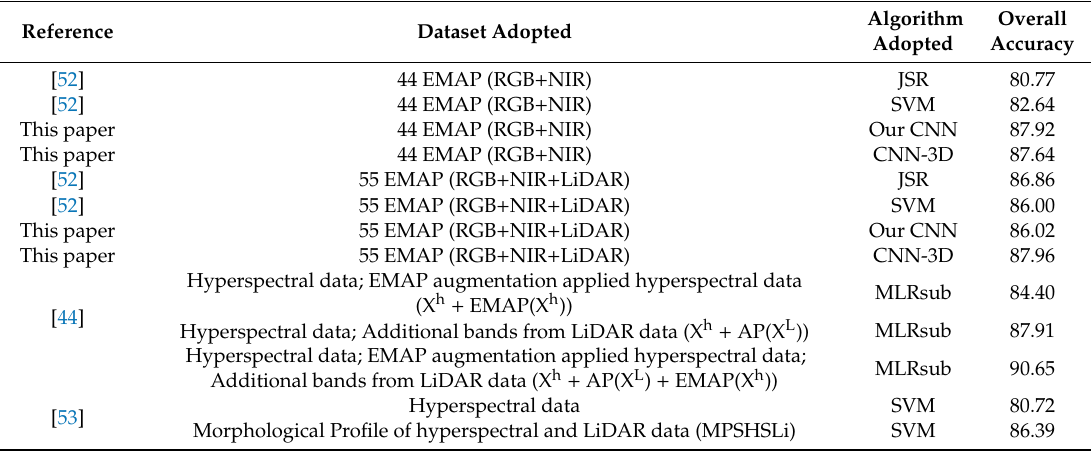
Table 5. Comparison of the overall accuracies (%) of several methods.